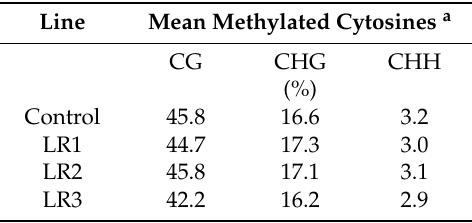
Table 2. Genome-wide DNA methylome analysis of rice epilines by bisulfite